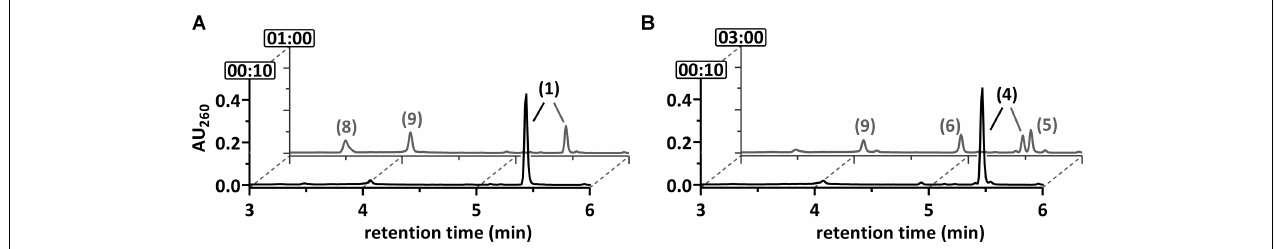
FIGURE 3 | Ultraperformance liquid chromatography (UPLC) diagrams demonstrating the time-dependent in vitro conversion of (A) 2-F-BzCoA and (B) BzCoA by cell-free extracts of T. aromatica . UPLC analyses of samples are shown, that were taken at representative time points as indicated by the numbers (min) at the y -axis. The peak numbers refer to those assigned to structures in Figure 1 : 2-F-BzCoA (1), BzCoA (4), 1,5-dienoyl-CoA (5), 6-OH-1-enoyl-CoA (6), 3-OH-pimeloyl-CoA (8), acetyl-CoA (9). Formation of 6-oxo-1-enoyl-CoA was not